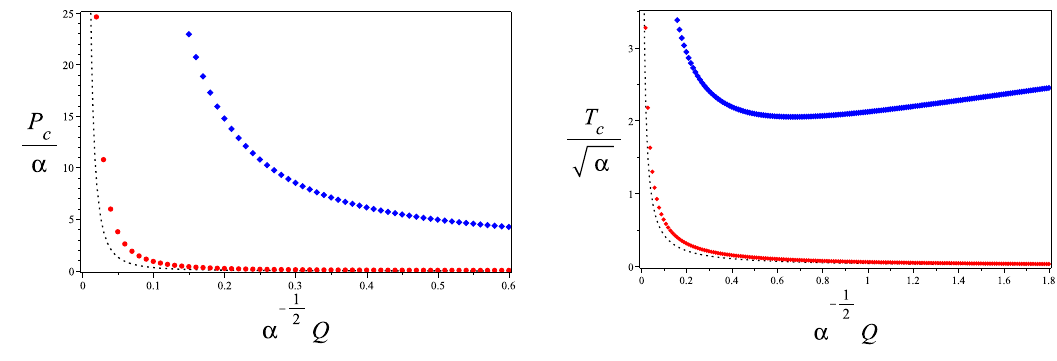
Figure 21 . Critical pressure (Left) and the critical temperature (Right) as function of (cid:22) Q . The red dots correspond to the RN-AdS-like critical points and the blue ones to the purely hairy ones. Black dotted lines correspond to the Reissner-Nordstr(cid:127)om-AdS black hole, given by equations (2.30). We see that the RN-AdS-like critical points for hairy black holes closely match with the critical p points for RN-AdS, merging with them as Q= (cid:11) gets